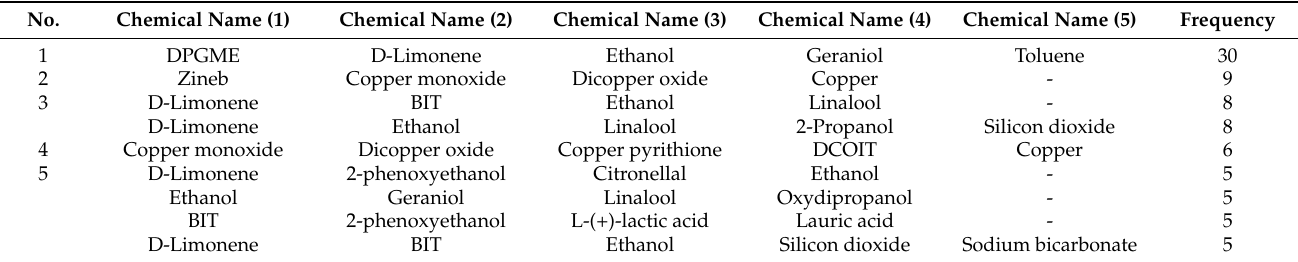
Table 5. Top five most frequently occurring four- or five-way combinations in combined exposure scenario database of biocides in South